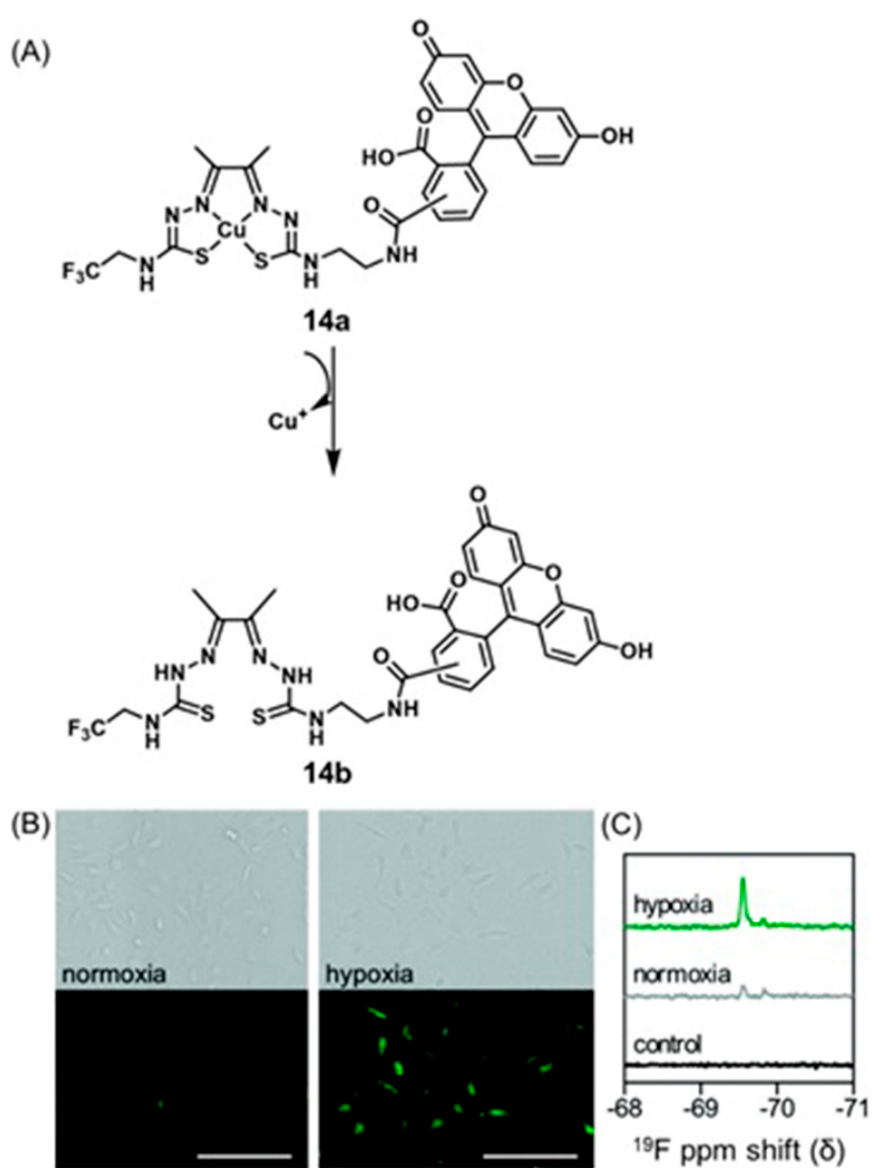
Figure 34. ( A ) Chemical structures and Cu I elimination reaction that 14a undergoes upon entering hypoxic cells. ( B ) Fluorescence images of normoxic [(left: brightfield (top) and fluorescence image (bottom)] and hypoxic [(right: brightfield (top) and fluorescence image (bottom)] of HeLa cervical cancer cells after 1 h incubation with 14a (30 μ M). Scale bar = 200 μ m. ( C ) 19 F-NMR spectra of lysed HeLa cells in anhydrous, d 6 -DMSO without incubating with 14a (control, bottom), normoxic cells incubated with 14a (60 μ M) for 1 h (normoxic, middle), and hypoxic cells incubated with 14a (60 μ M) for 1 h (hypoxia, top). Adapted with permission of the Royal Society of Chemistry, from A dual-responsive probe for detecting cellular hypoxia using 19 F magnetic resonance and fluorescence. Kadakia, R. T.; Xie, D.; Martinez D. Jr.; Yu, M.; Que, E. L. 55 , 60, 2019 ; permission conveyed through Copyright Clearance Center, Inc. [316].